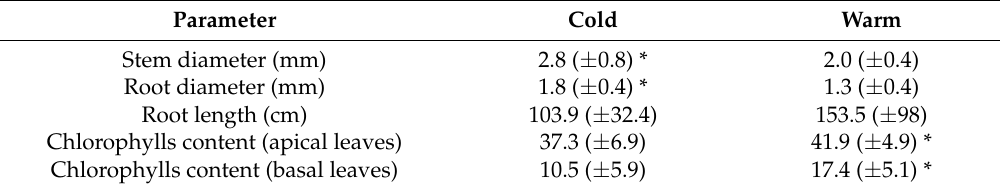
Figure 5. Mean number with standard error of new and dead leaves per week in the two lighting conditions. Table 3. Dimensions of morphological parameters at the end of the growth period: mean (standard deviation).